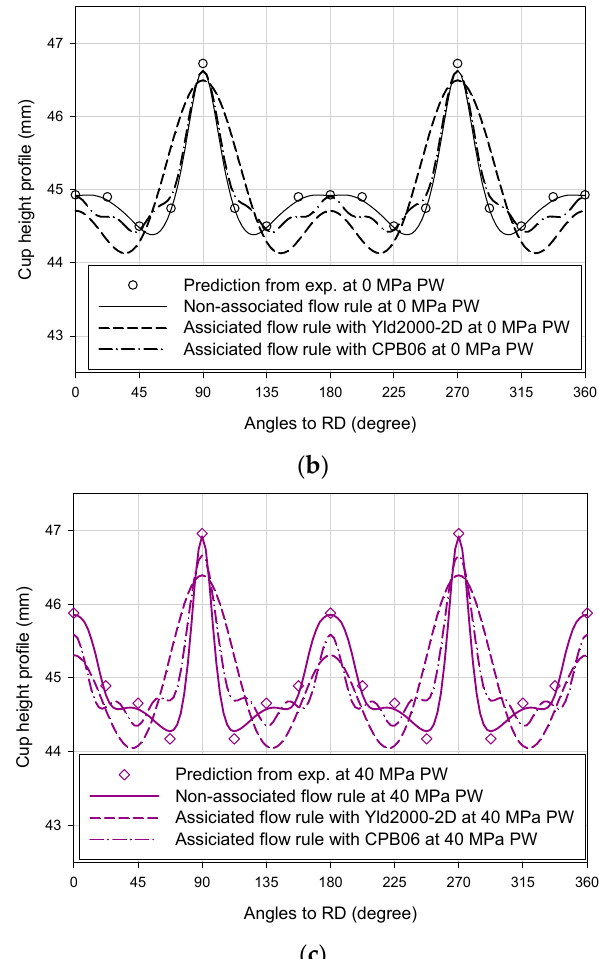
Figure 20. Comparison of the predicted cup height profiles: ( a ) based on the non-associated flow rule with Yld2000-2D functions; ( b ) based on the associated flow rule with Yld2000-2D and CPB06ex3 functions at 0 MPa of the accumulated plastic work; ( c ) based on the associated flow rule with Yld2000-2D and CPB06ex3 functions at 40 MPa of the accumulated plastic work.